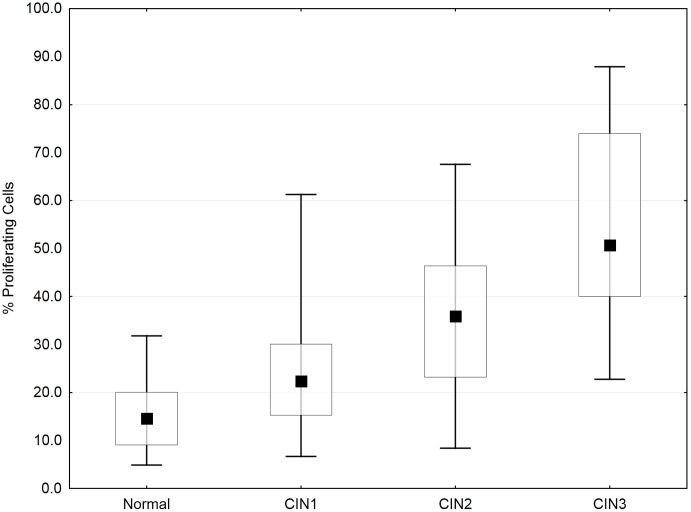
Proportion of Mib1-positive cells (i.e. proliferating cells) in the four diagnostic groups.The mid-point represents the median value; boxes represent the 25th percentiles; and whiskers represent the 95th percentiles. Once again, factorial ANOVA testing was followed by a post hoc Fisher LSD test for group-by-group comparisons, yielding: p = 0.0006 for a normal vs. CIN1 comparison; p = 0.017 for a normal CIN1 vs. CIN2 comparison; and p = 0.00001 for a CIN2 vs. CIN3 comparison.